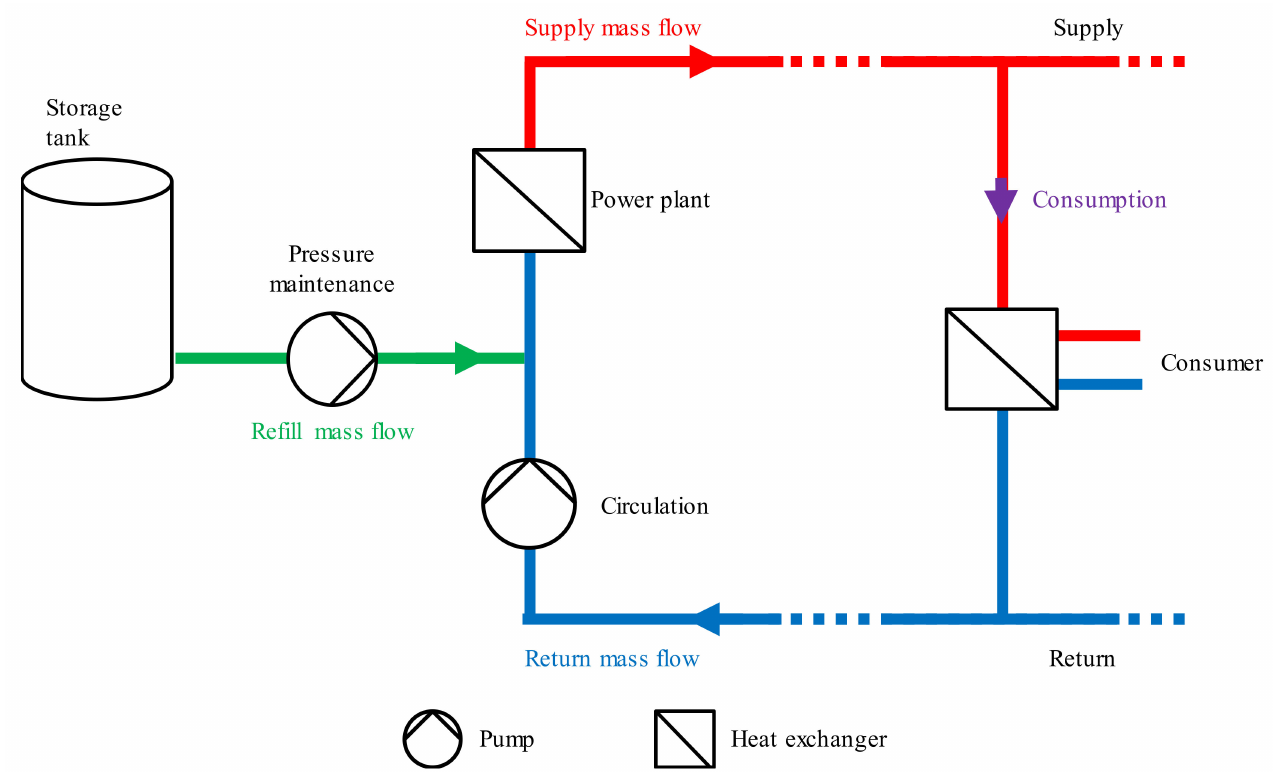
Figure 1. Schematic representation of a district heating